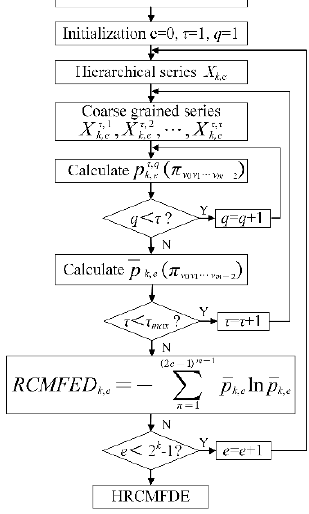
Figure 3. The flowchart of HRCMFDE.